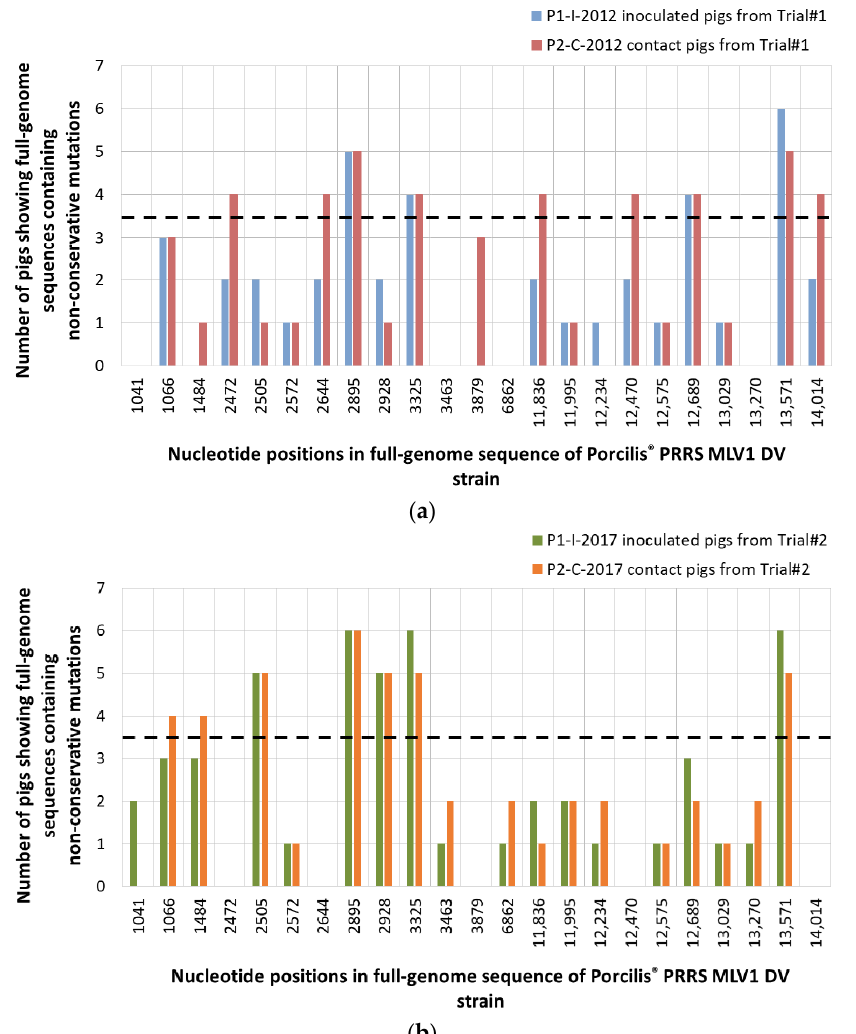
Figure 7. Distribution of the non-conservative mutations among inoculated and contact pigs from Trial#1 ( a ) and from Trial#2 ( b ), using the P0-2012 or the P0-2017 sequences as references, respectively. Mutation locations were indicated in the nucleotide sequence starting from the first nt of the 5 ′ nontranslated region (5 ′ NTR) on the KF991509.2 full-length sequence. Mutations were considered as significant when occurred in at least 4/6 pigs (dotted line).